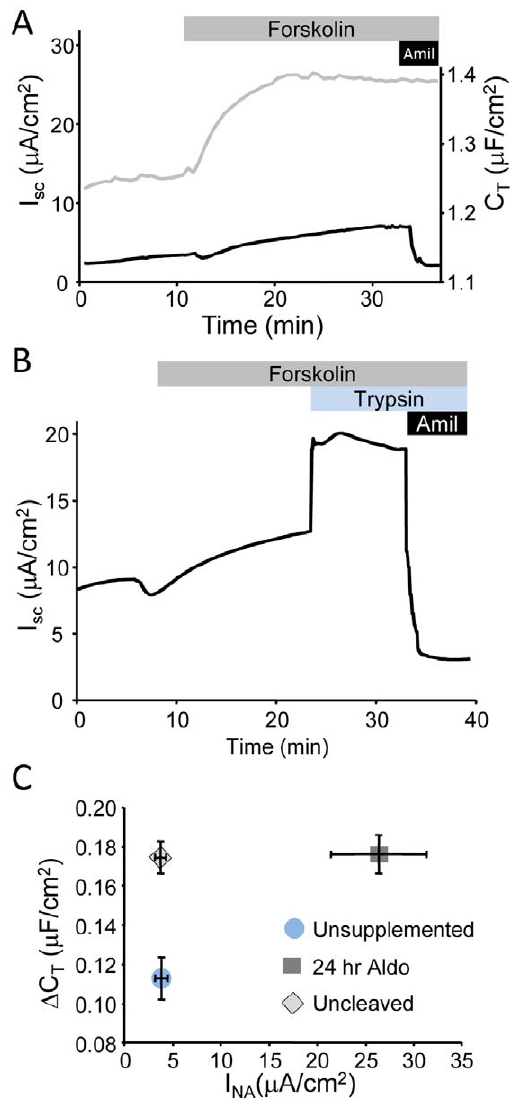
Figure 4. Inhibiting ENaC activity does not alter trafficking. (A) Representative I SC (black trace) and C T (grey trace) traces from mpkCCD cells pretreated with 50 m M FCI for 24 hrs before recordings and stimulated with forskolin (10 m M). (B) Single I SC recording from FCI inhibited cells (as in A) where 1 m M trypsin was added to the apical bath (light blue bar) to activate uncleaved channels. (C) Summarized I SC versus D C T plots for control unsupplemented, aldosterone treated and aldo + FCI treated cells (n . 16 per point). The D C T for uncleaved channels was significantly greater (p , 0.01) than the unsupplemented controls, but not significantly different from aldosterone stimulated